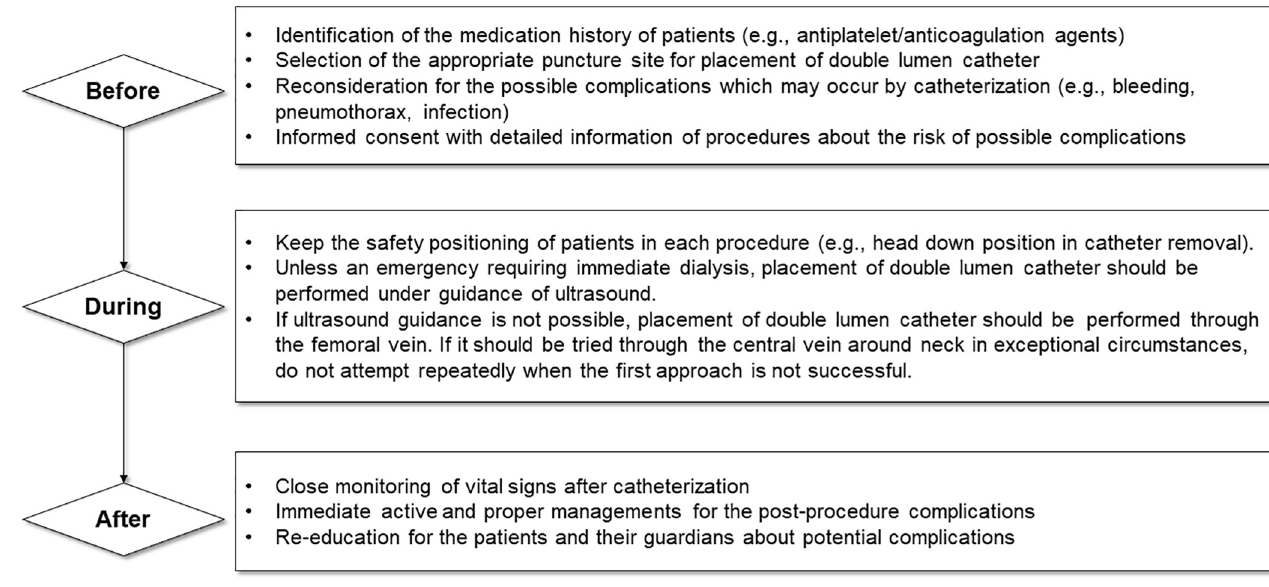
Fig 3. Recommendations for the prevention of malpractices during hemodialysis catheter-related procedures.